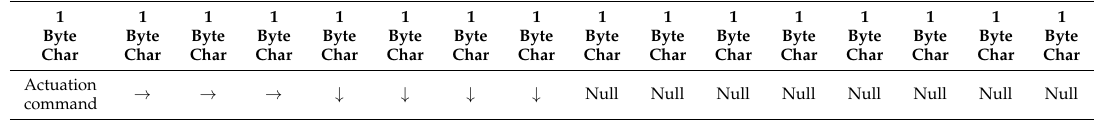
Figure 10. Smart surface Image with an object (red filled circle), solenoid valves holes (“+” signs in violet color), the desired object location (blue circle) and the calculated conveyance trajectory of the object (blue flashes). Table 1. Composition of an actuation command. Table 1. Composition of an actuation